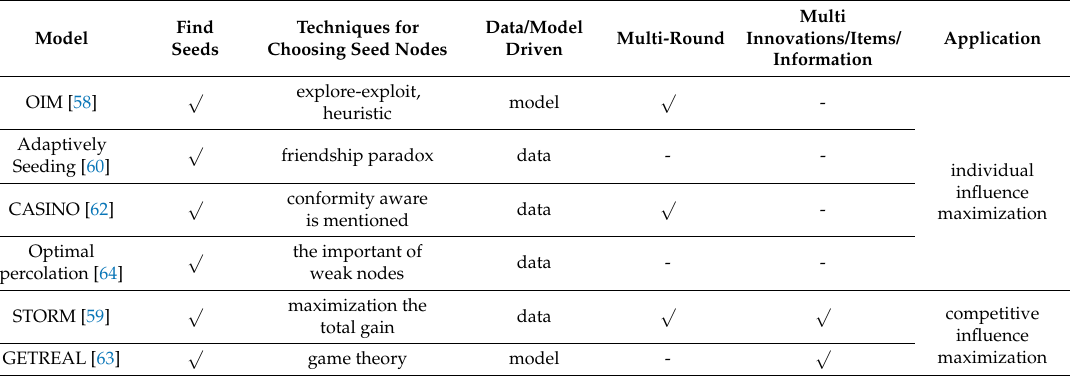
Table 4. Comparison of Influence Maximization